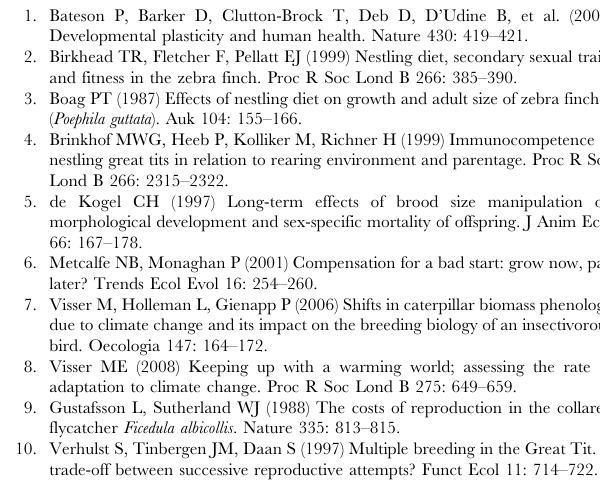
Table S1 Raw means 6 s.e. for all biometric measurements and timepoints. Until day 17 subjects fed either on a low quality (L) or high quality (H) diet. Post day 17 subjects belonged to either LH = low-high (L as nestlings), HL = high-low (L as fledglings) or HH = high-high (H throughout) treatment. N = number of nests n = subjects came